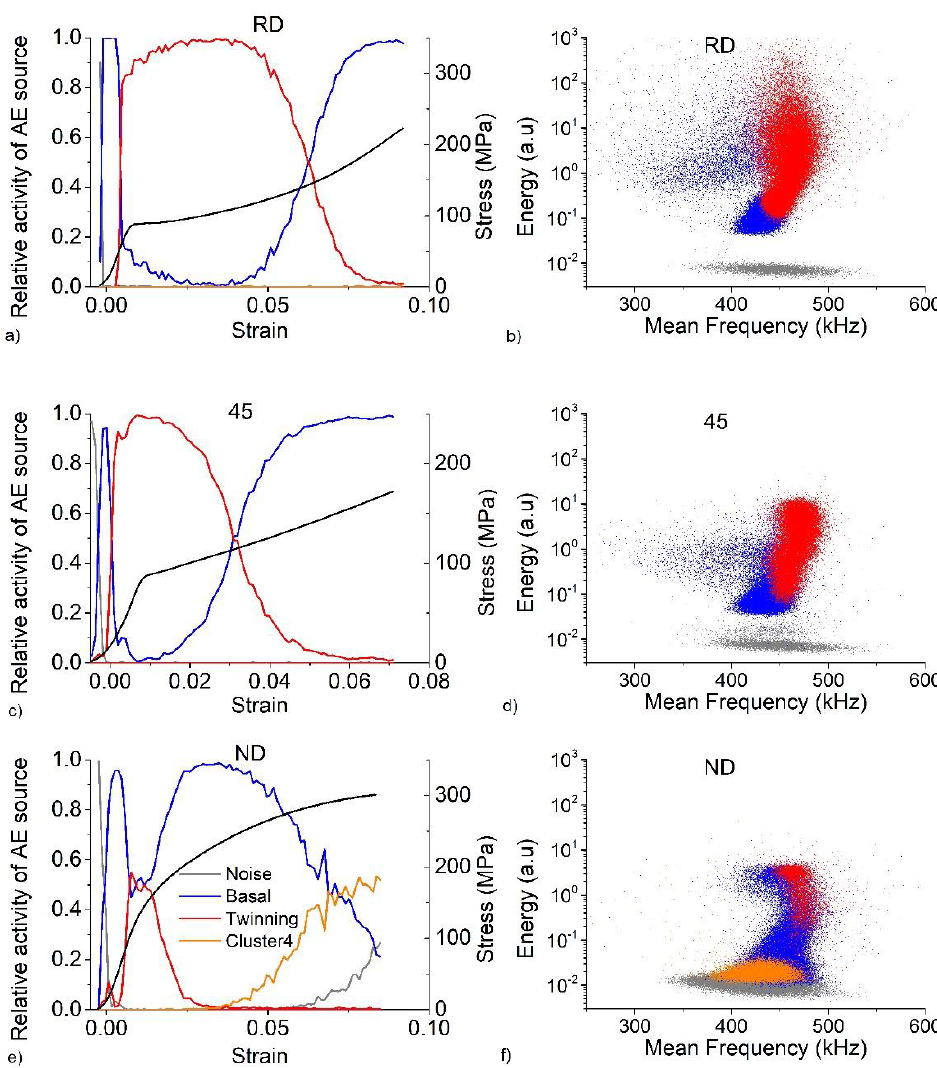
Figure 6. Relative activity of AE sources evaluated by the ASK analysis ( a,c,e ) and the projection of the clusters in the 2D mean frequency vs. energy diagrams ( b,d,f ).